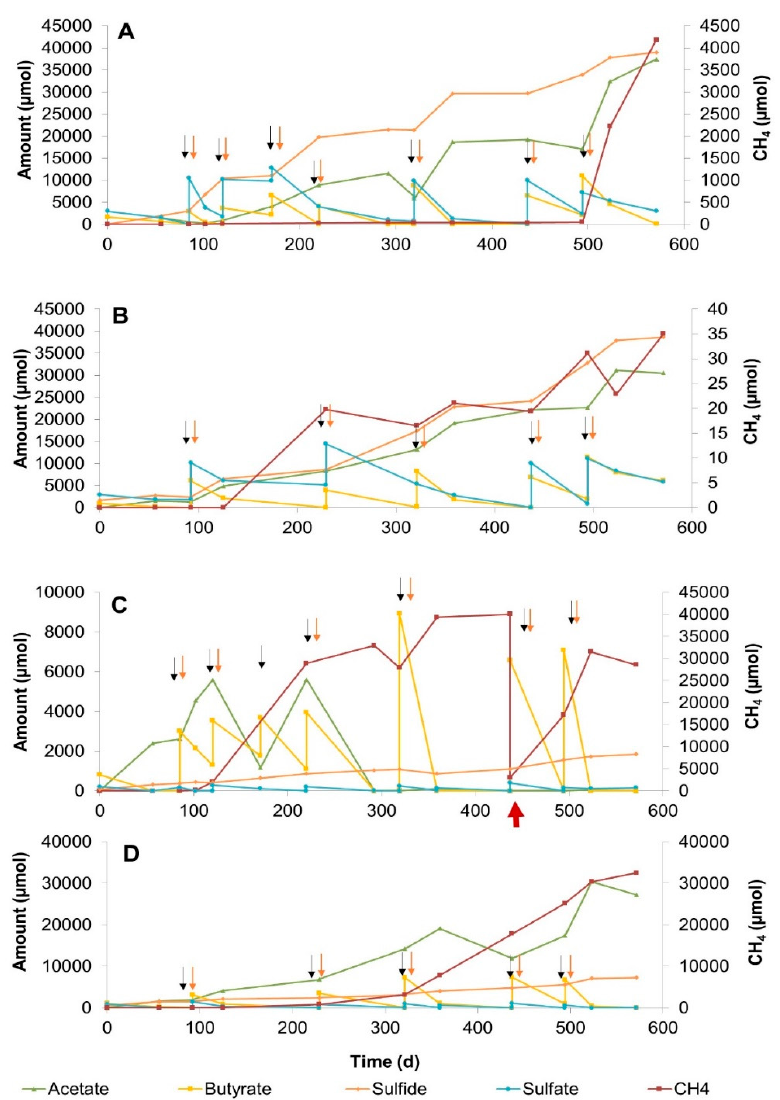
Figure 2. Changes in butyrate, sulfate, acetate, sulfide, and methane concentrations during 571 days of incubation in sediment slurry enrichments constituted of sulfate–methane transition zone sediment. ( A ) Slurry SMTZB3, with 20 mM sulfate addition at 25 °C, ( B ) Slurry SMTZB7, with 20 mM sulfate addition at 10 °C, ( C ) Slurry SMTZB1, with 3mM sulfate addition at 25 °C, ( D ) Slurry SMTZB6, with 3mM sulfate addition at 10 °C. Arrows denote the time points for the additions of sulfate (red) and butyrate (black). The red arrow in Figure 2C indicates the time point that the excess amount of gas was exhausted from the headspace.